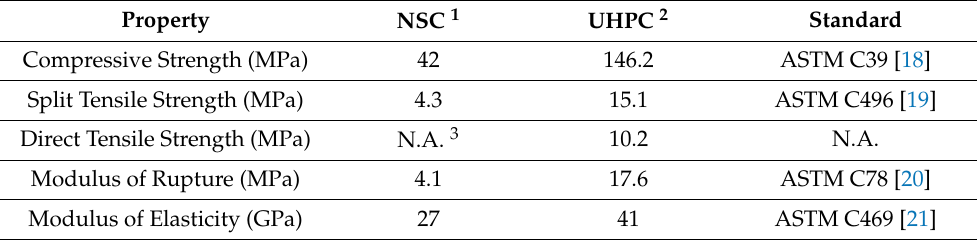
Table 3. Material properties of NSC and UHPC.